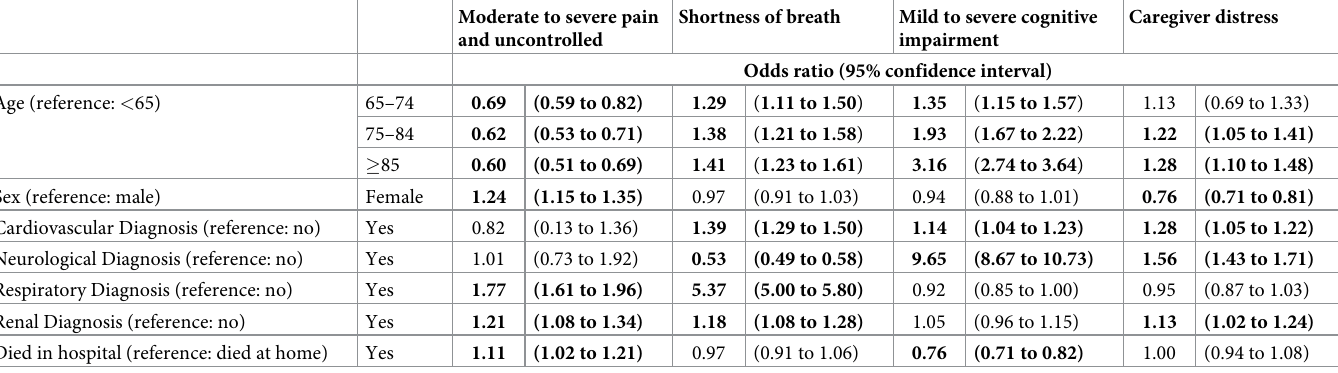
Table 2. Adjusted odds ratio of having symptoms (moderate to severe pain, shortness of breath, cognitive impairment, caregiver distress, self-reported poor health) in the last six month of life using multivariate logistic regression analysis controlling for covariates �